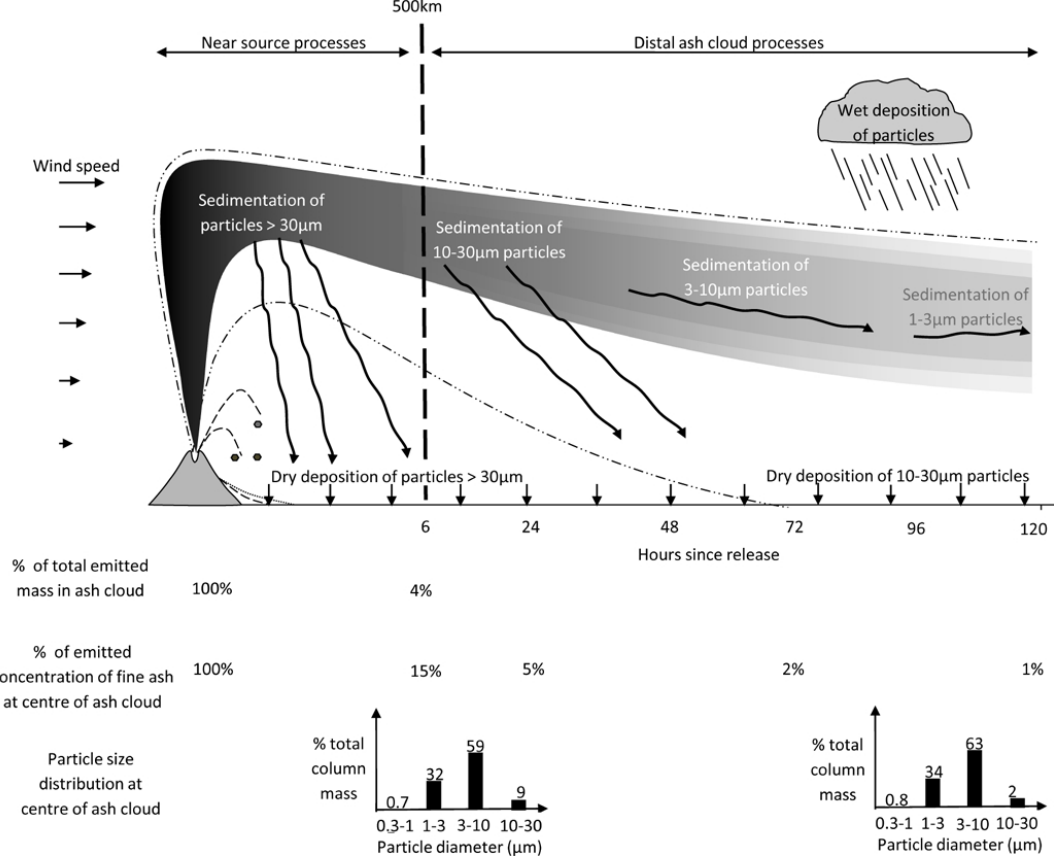
Fig. 13. Schematic showing the processes controlling the evolution of the fine ash concentration and particle size distribution in the distal ash cloud for the Eyjafjallaj¨okull tropospheric eruption. The grey shadings represent the fine ash concentration, with 1% peak column concentrations represented by dash-dot contour. Fine ash refers to small particles ( < 30µm diameter). Note that, for other eruptions, the fine ash concentration and particle size distributions are likely to depend on the magnitude of the